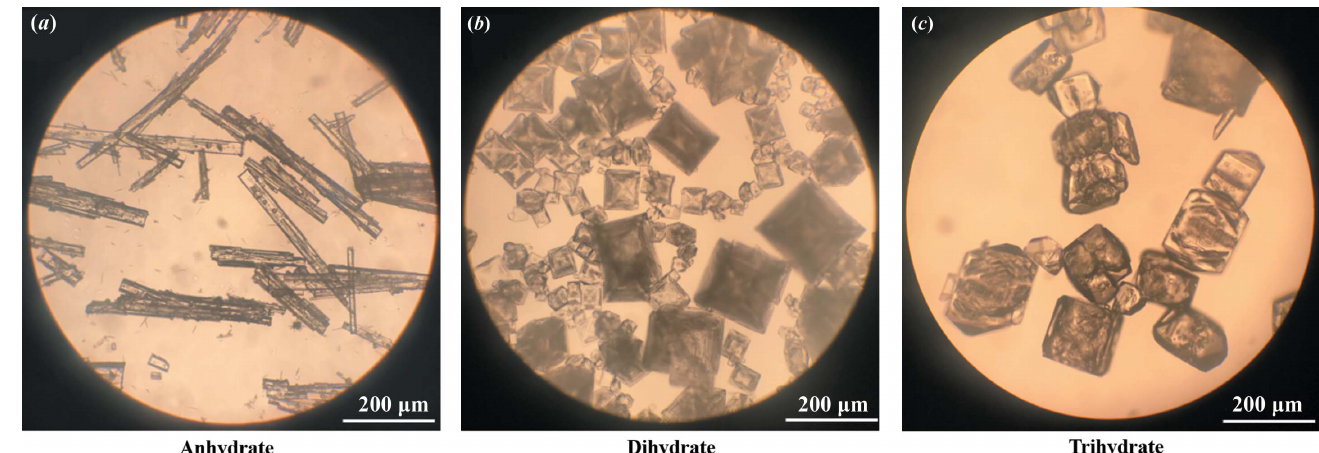
Figure 3 Optical micrographs of crystals obtained in experiments: ( a ) anhydrate, ( b ) dihydrate, ( c ) trihydrate. The magnifications are 16 (cid:8)